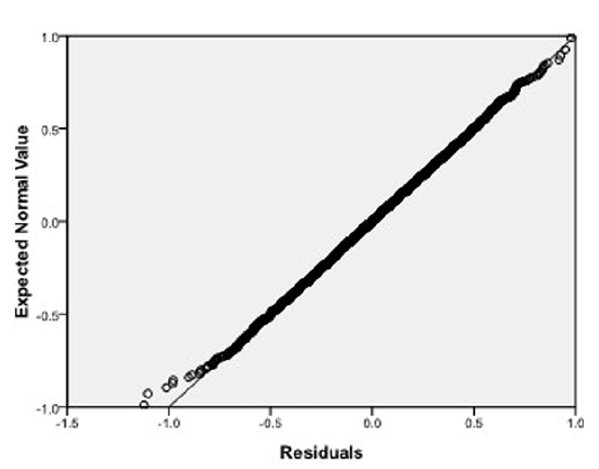
Figure 30. Normal Q-Q plot of residuals of ^ bb 2 of OLS when the z x 2 )) . variance function of the error term is s 2 ( x 1 , x 2 ) ~ exp ( { ( x 2 1 2